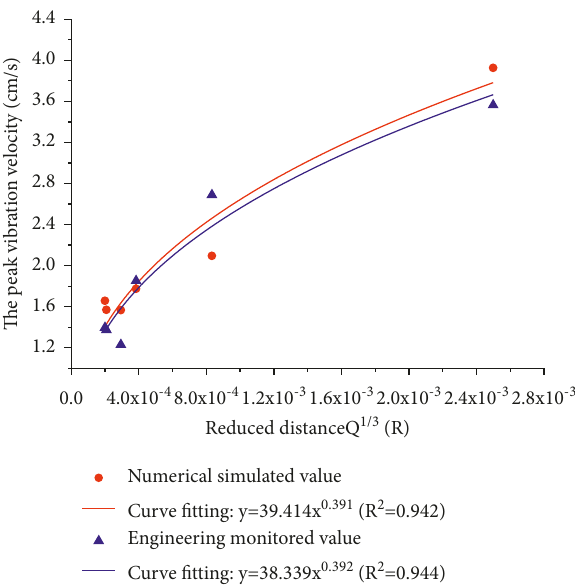
Figure 11: Solving diagram of seismic wave absorption coefficient.